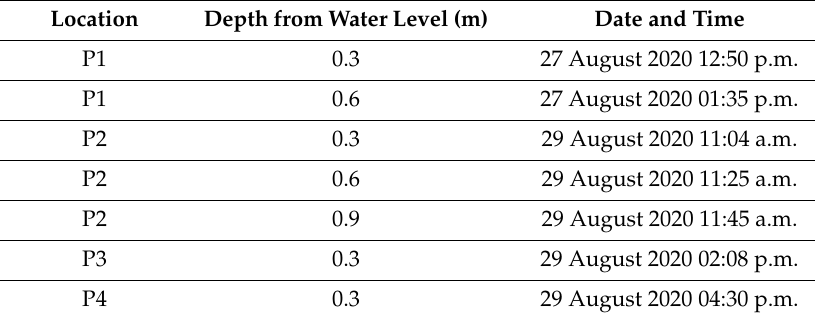
Table 1. Characteristics of data collection